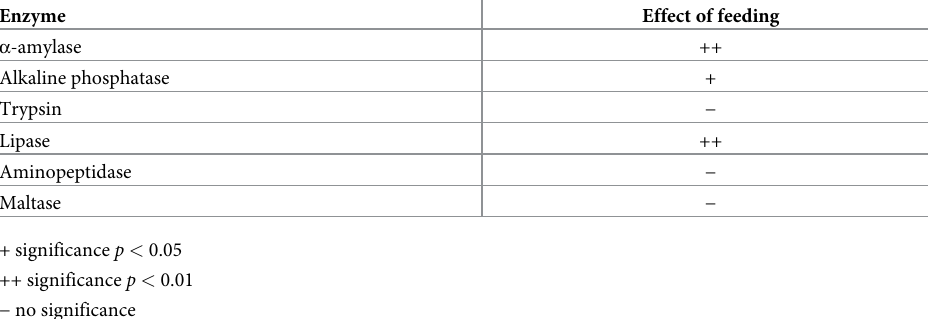
Table 2. Summary table of the effect of feeding on α - amylase, maltase, lipase, trypsin, aminopeptidase, and alka- line phosphatase tissue activities in the Pacific hagfish alimentary canal.